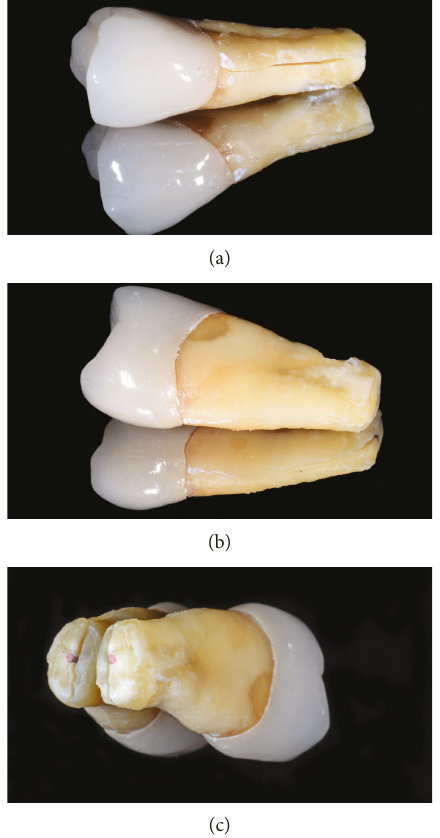
Figure 11: Extraoral close readaptation of fragments: the fracture runs for the entire bucco-lingual length of the tooth, as shown by separation on the vestibular (a) and palatal (b) sides. The fracture line was o ff -centered from the canal when observed on the axial plane (c).